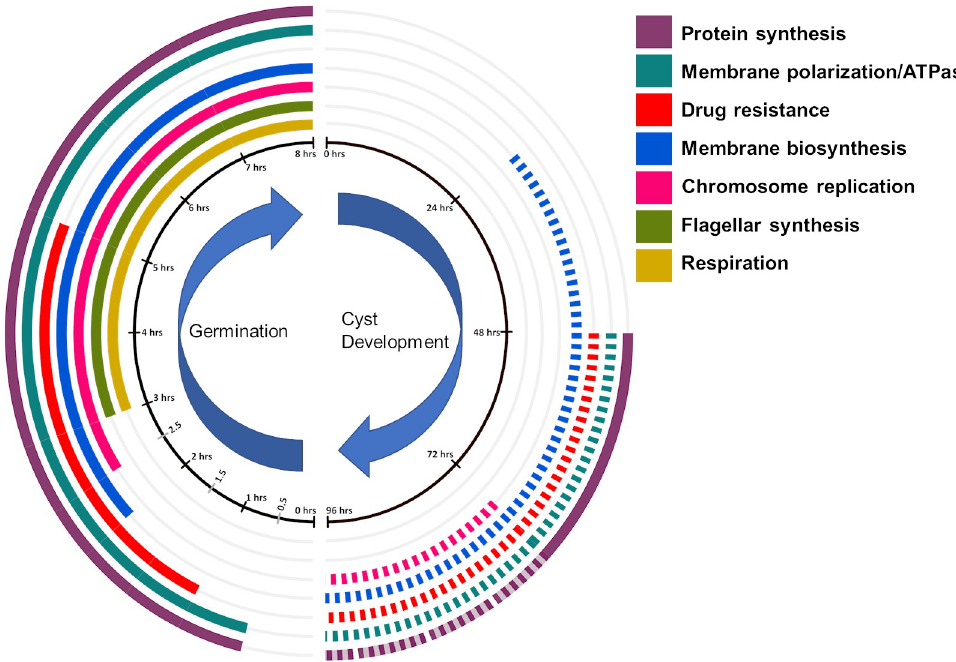
Fig 7. Lifecycle clock summarizing pathways and processes that are differentially regulated during the development of cysts versus cyst germination. Solid lines indicate up-regulation in expression while dotted lines indicate down- regulation. Colored transparent lines indicate periods of no changes in